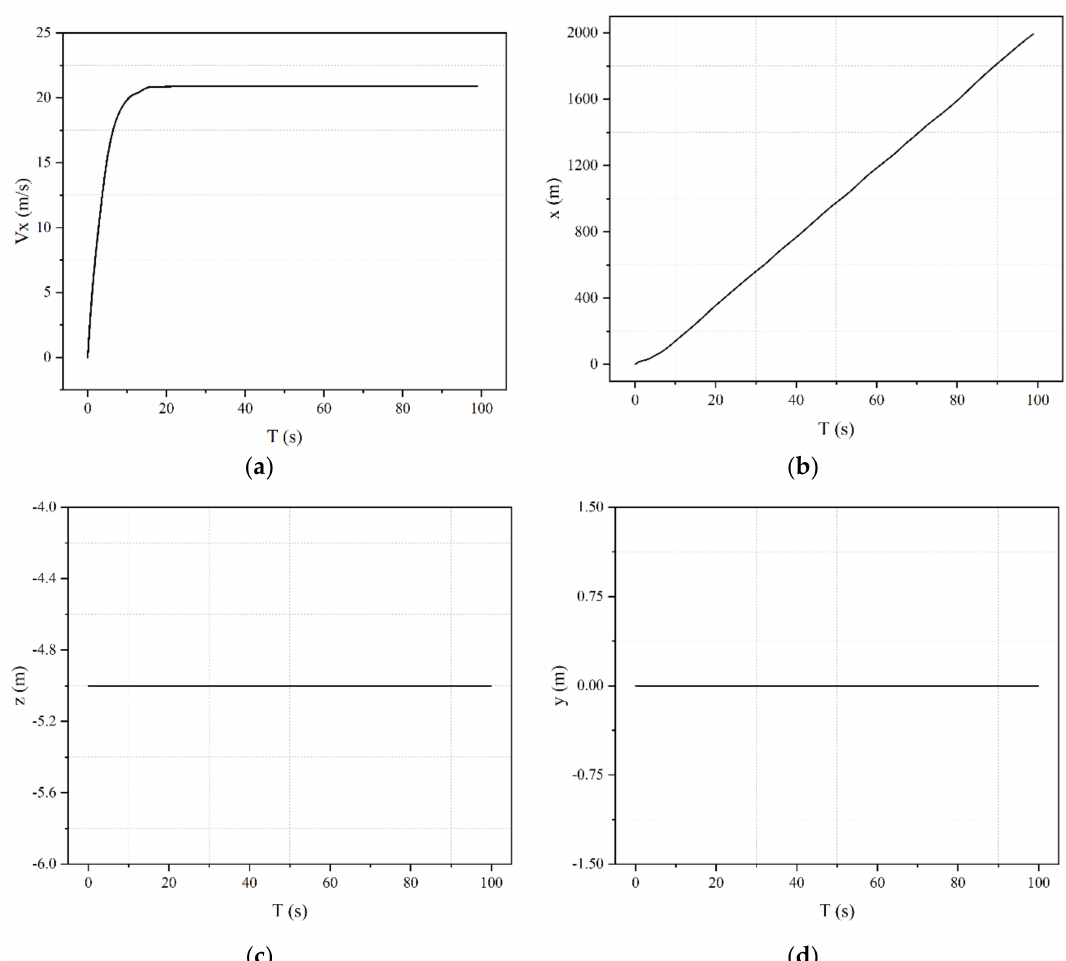
Figure 2. Validation results: ( a ) torpedo’s speed in the x -direction; ( b ) horizontal displacement in the x -direction; ( c ) torpedo’s navigation depth; ( d ) torpedo’s lateral